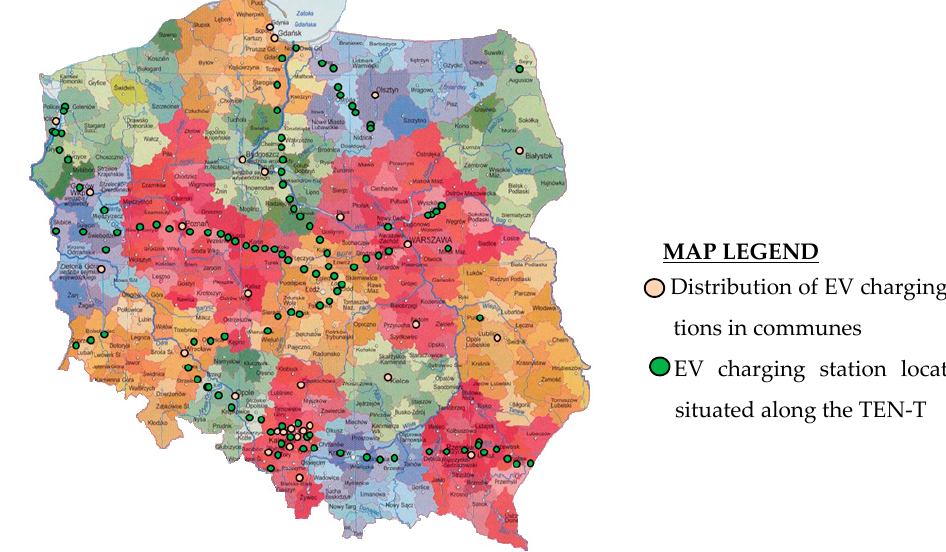
Figure 8. Location of charging points in Poland according to the Act of 11 January 2018 on electromobility and alternative fuels.